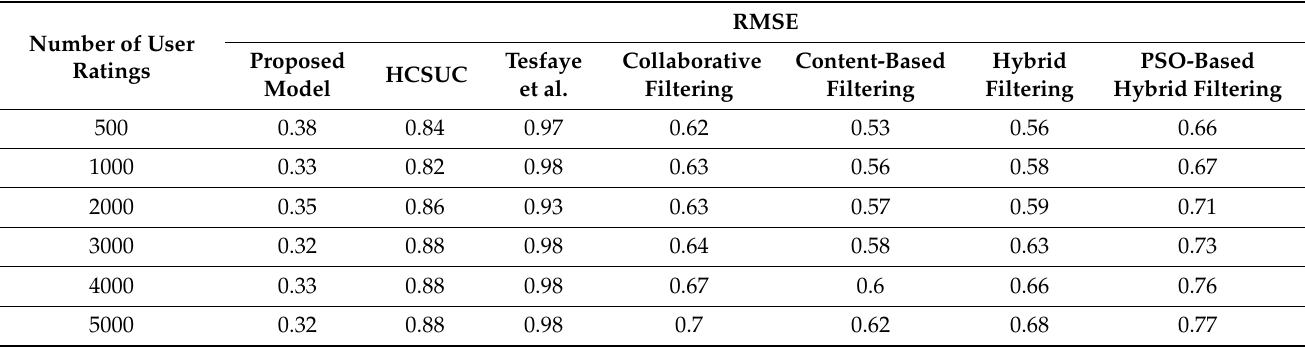
Table 18. Comparison of RMSE with the proposed model and existing